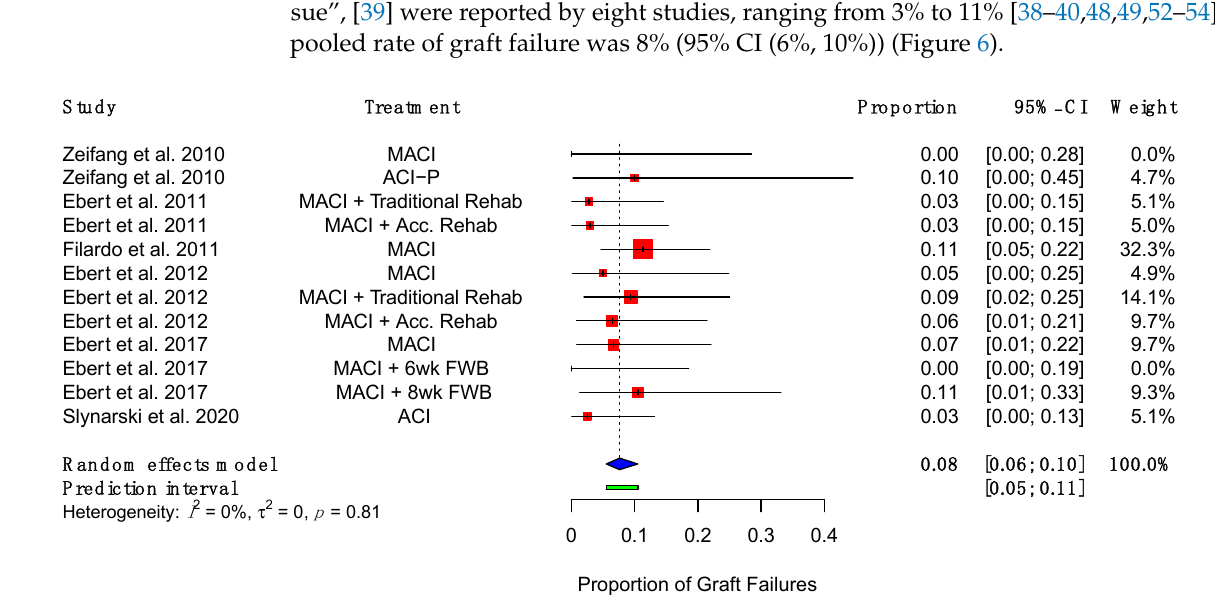
Figure 6. Forest plot on the proportion of implanted grafts which failed. (Abbreviations: MACI, Matrix-induced autologous chondrocyte implantation; ACI-P, ACI with periosteal flap cover; Acc., accelerated; FWB, full weight-bearing; CI, Confidence Intervals).